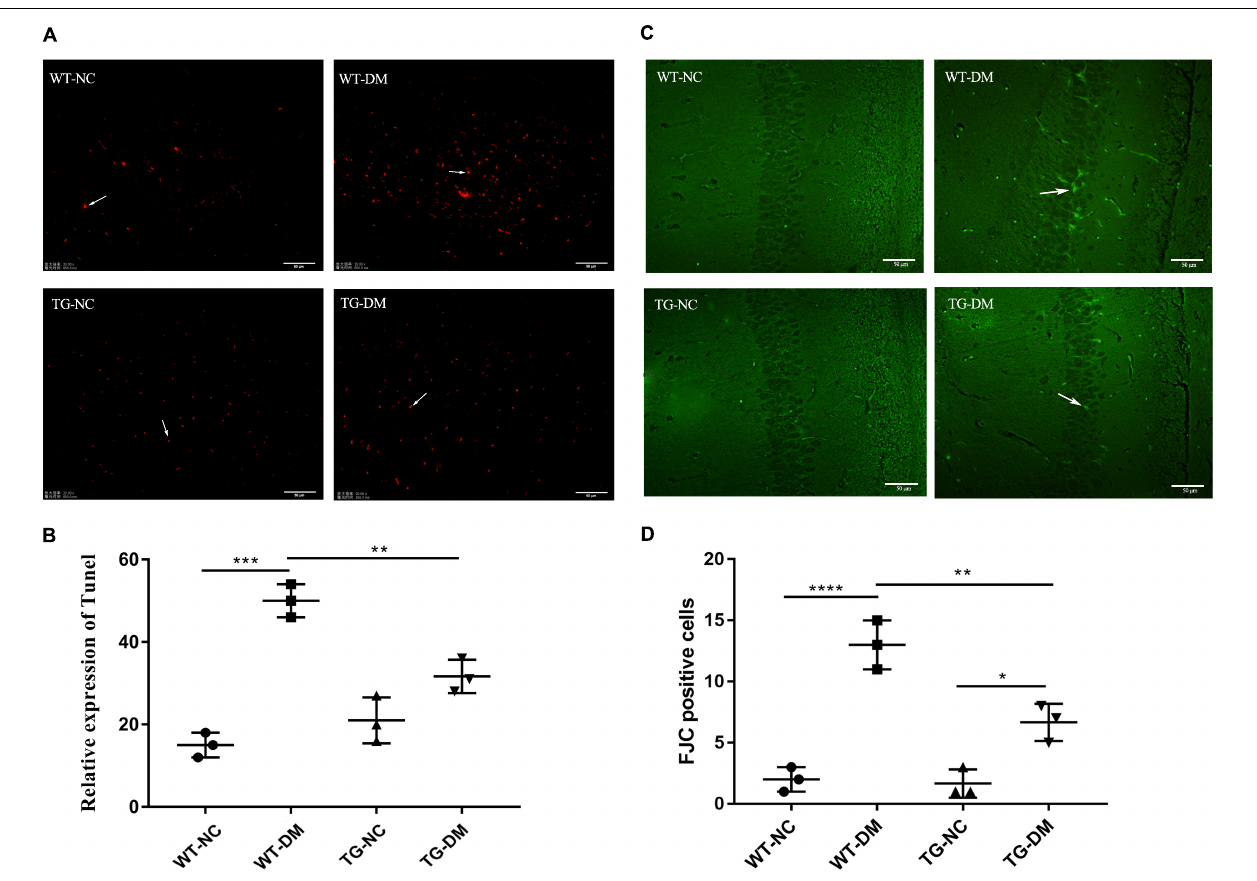
FIGURE 2 | Trx-1 significantly inhibits DM-induced apoptosis and neural degeneration in the hippocampal region. (A) Positive cells with a red fluorescence signal (white arrows) were present in the hippocampal as determined by the TUNEL assay. (B) Quantitative statistical analysis of TUNEL-positive cells. (C) Representative images of FJC-positive staining (white arrows) in the hippocampal regions. (D) Quantitative statistical analysis of FJC-positive cells. Tukey’s post hoc test for one-way ANOVA used for TUNEL test. For each group, n = 6. The vertical lines represent the standard error of the mean. * p < 0.05, ** p < 0.01, *** p < 0.001, **** p <